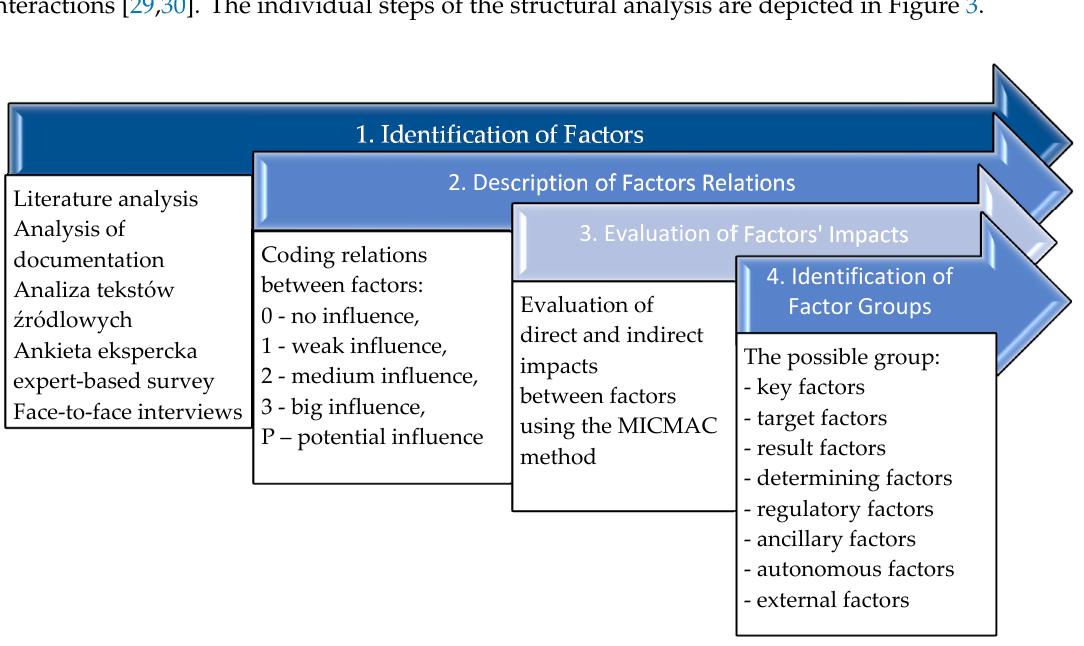
Figure 3. Structural analysis stages. Own study based on [28].